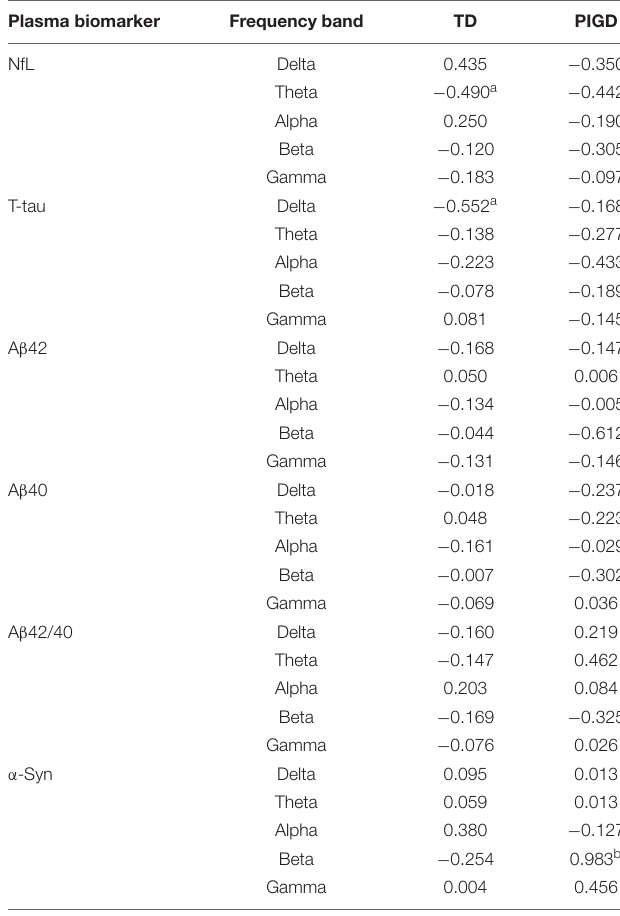
TABLE 4 | Correlation between plasma biomarkers and TT